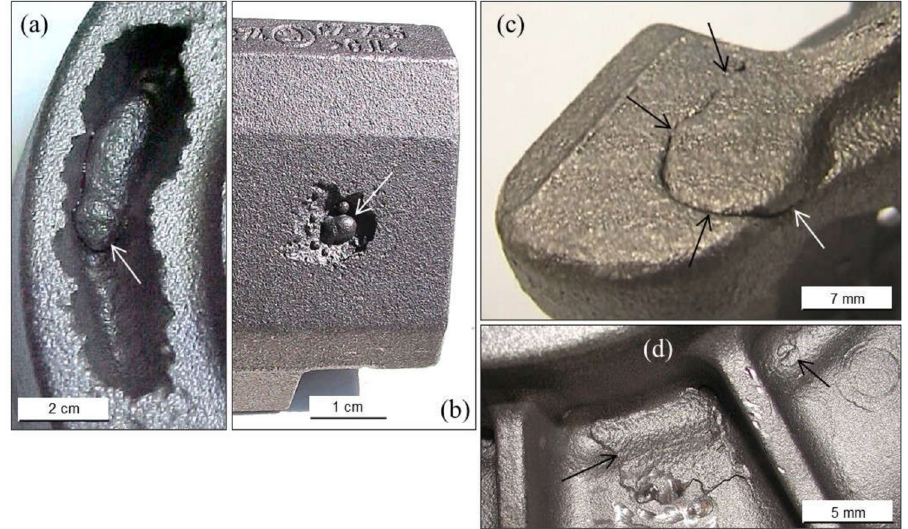
Figure 10. ( a , b ) open blowholes with rounded protuberances inside found in grey iron castings; ( c , d ) blister blowholes found in the upper area of a ductile iron